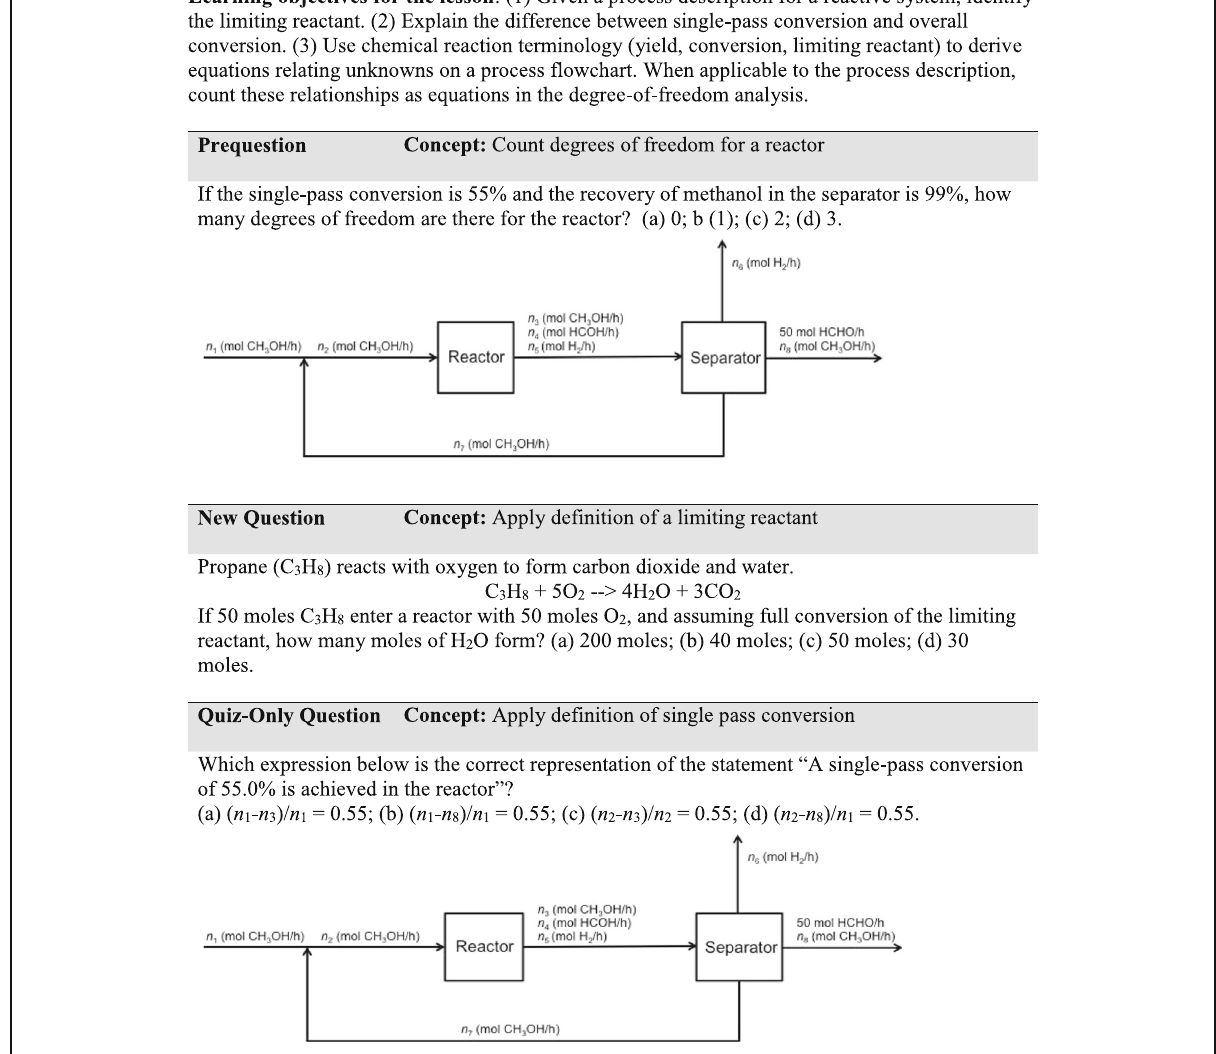
Fig. 1 Representative three-question set for a lesson (adapted from Koretsky et al., 2014). This example illustrates the alignment of questions with the learning objectives for the lesson and the independence between